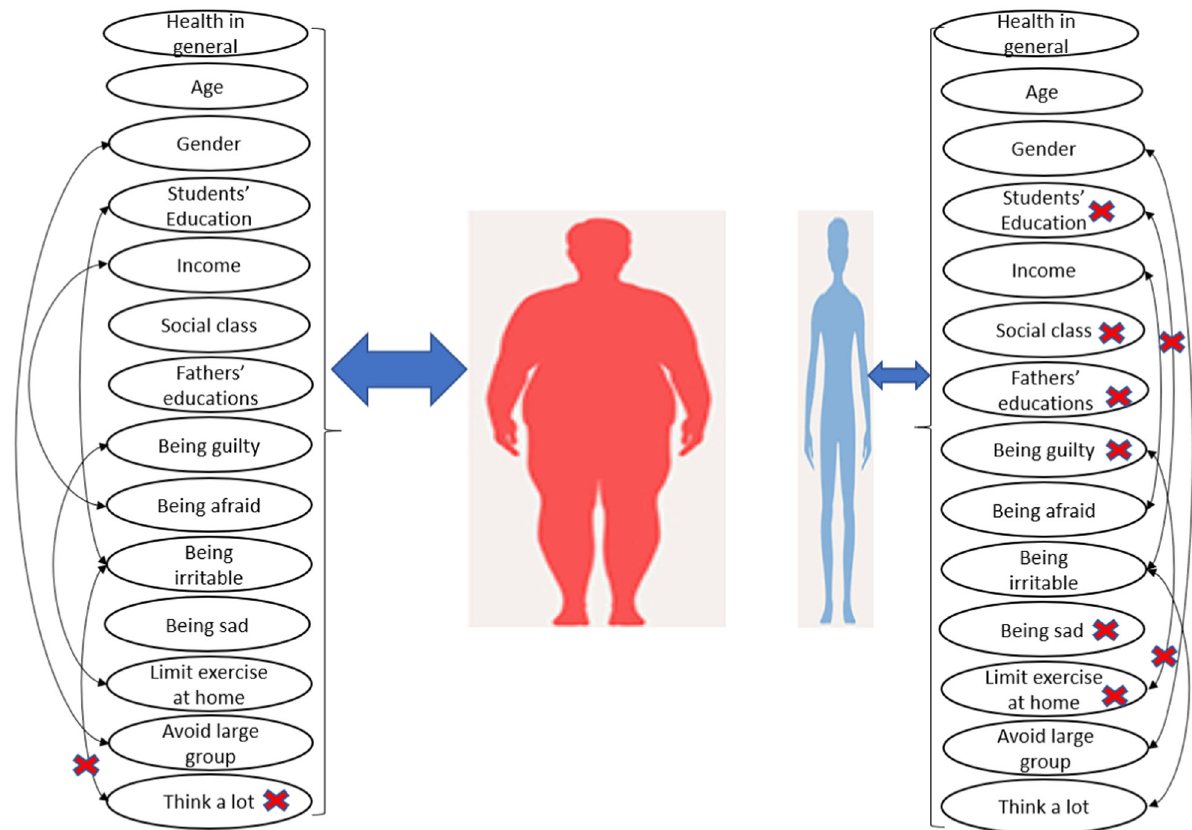
Fig. 1 Associated factors with over-weight and underweight students, the insigni fi cant parameters and interaction terms are